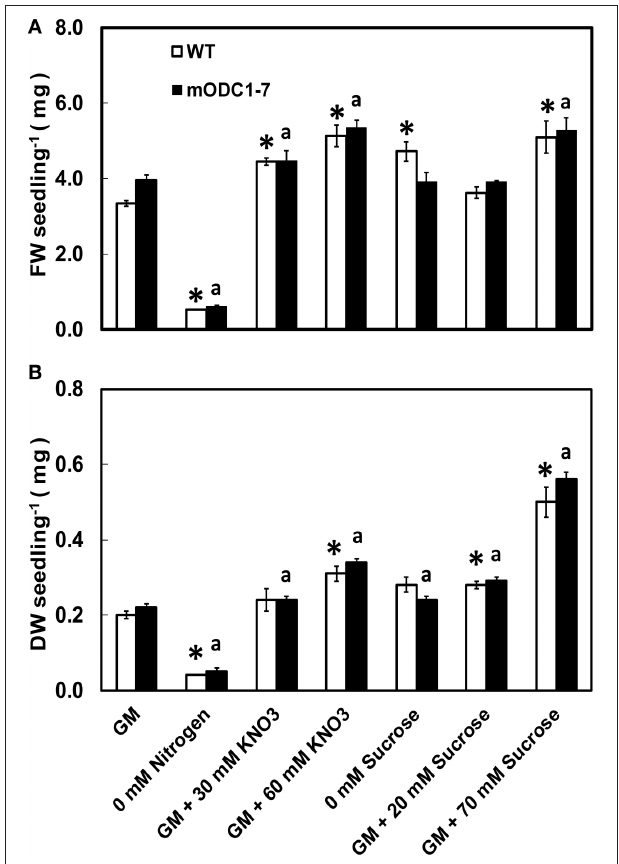
FIGURE 2 | Effects of different concentrations of nitrate and sucrose on (A) fresh weight (FW) and (B) dry weight (DW) of 12 day old WT and 2x 35S ::m ODC -1-7 transgenic Arabidopsis thaliana seedlings grown on solid GM. Data are mean of 4 ± SE; each replicate consists of 40–50 seedlings. * Denotes significant difference between treatments and control in WT seedlings and a denotes significant difference between treatments and control in m ODC seedlings ( P ≤ 0.05